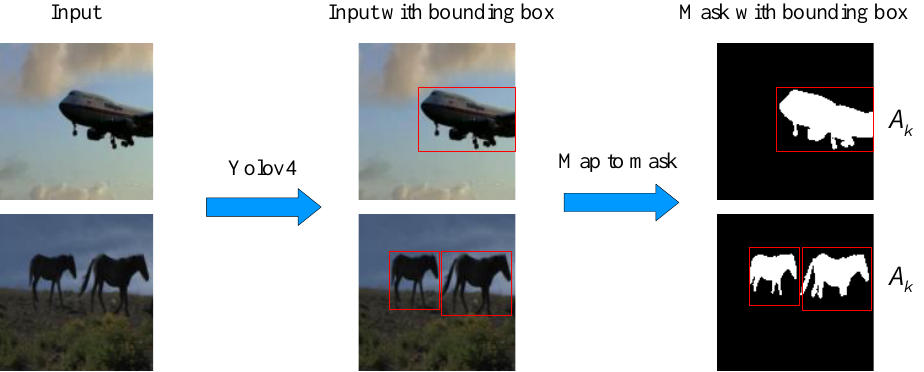
Figure 2. The operation of extracting object location information. We obtain the bounding box of the object from a pretrained Yolov4 [30]. The bounding box is then mapped into the segmentation mask, and the object area A k is